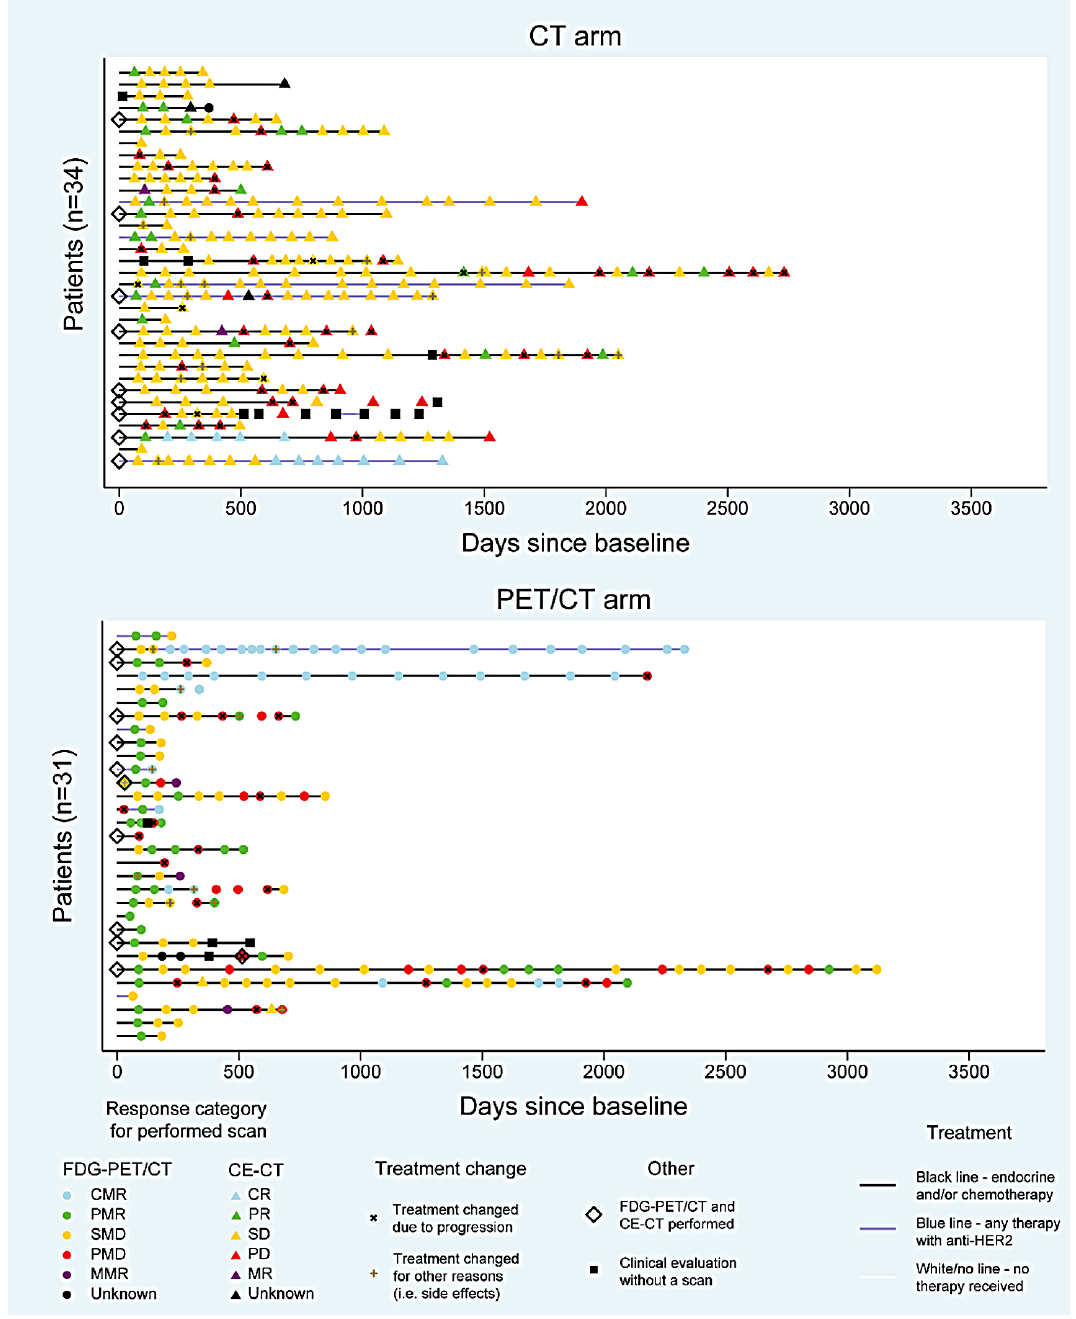
Figure 2. Visualization of response categories and treatment changes for study groups (CE-CT: contrast-enhanced computed tomography; FDG-PET/CT: fluorodeoxyglucose positron emission tomography with integrated computed tomography; CR: complete response; PR: partial response; SD: stable disease; PD: progressive disease; MR: mixed response; CMR: complete metabolic response; PMR: partial metabolic response; SMD: stable metabolic disease; PMD: progressive metabolic disease; MMR: mixed metabolic response).